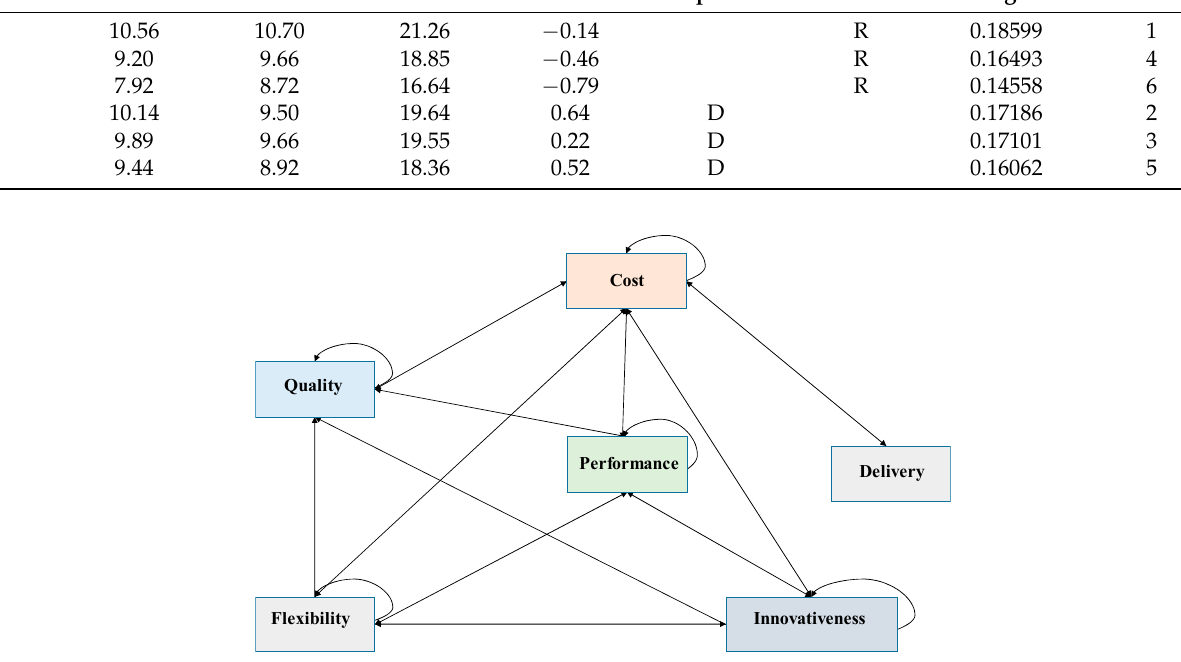
Figure 5. Interrelationships among MSOs.